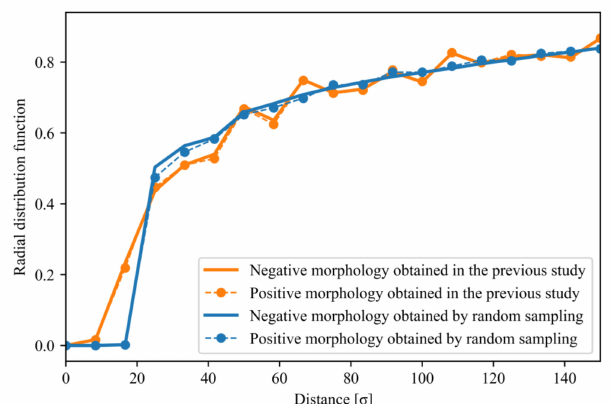
Figure 2. RDFs of the filler particles in the positive and negative examples. The blue lines denote the RDFs of the morphologies obtained by random sampling, and the orange lines represent the RDFs of the morphologies obtained in the previous study. The solid and dotted lines show the RDFs of the negative and positive examples,